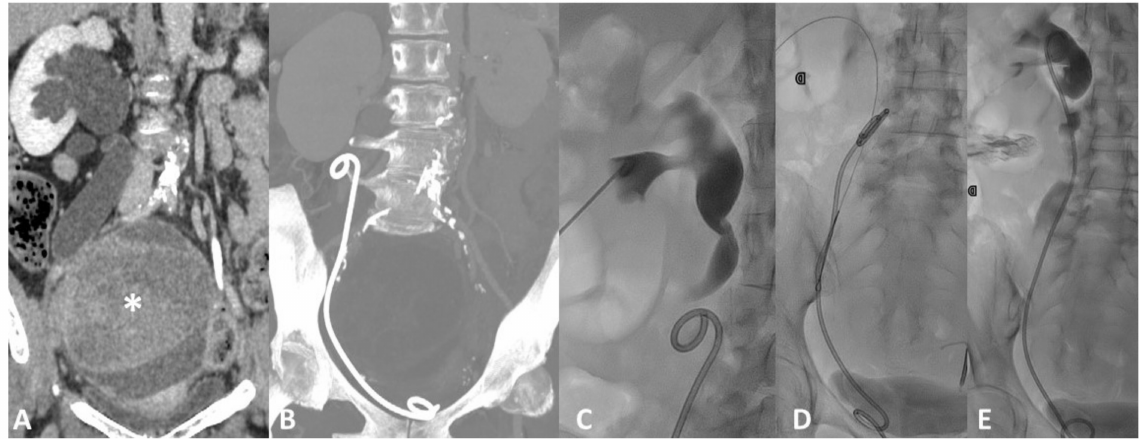
Figure 5. Device migration. Forty-six-year-old female with rapid onset of right flank pain ad diuresis reduction 3 months after ureteral stent placement for marked hydroureteronephrosis ( A ) caused by an ovarian mass (*). Follow-up CT scan ( B ) shows displacement of the ureteral stent, slipped down in the urinary tract. Fluoroscopic image ( C ) shows the consequent dilatation of the renal pelvis and calyces with stasis of contrast medium caused both by the malfunction of the displaced device and by the mechanical obstruction caused by the stent itself inside the ureter. Percutaneous Stent retrieval with a goose neck snare catheter ( D ) and replacement ( E ) was the treatment of